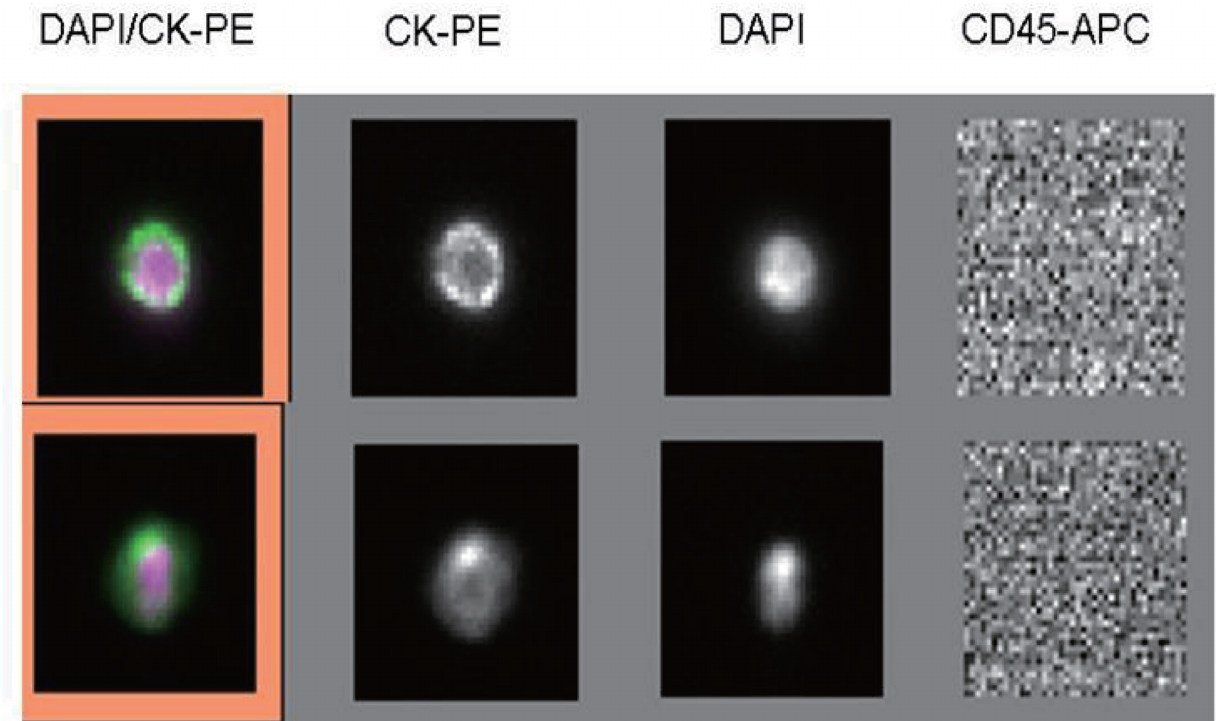
Fig 1. Immunostaining of a single lung cancer CTC isolated from patient peripheral blood. Positive immunomagnetic selection with anti-EpCAM Ab was followed by morphological confirmation with staining for cytokeratins (cytoplasm), DAPI (nucleus), and CD45 (negative).